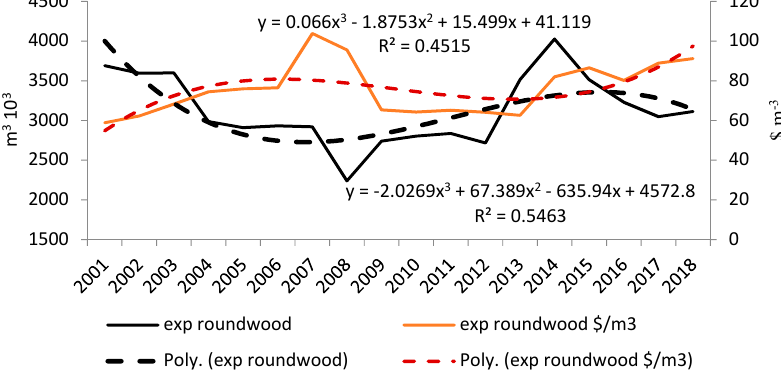
Figure 2. Volume (left axis) and prices (right axis) of beech roundwood exports in the years 2001–2018.